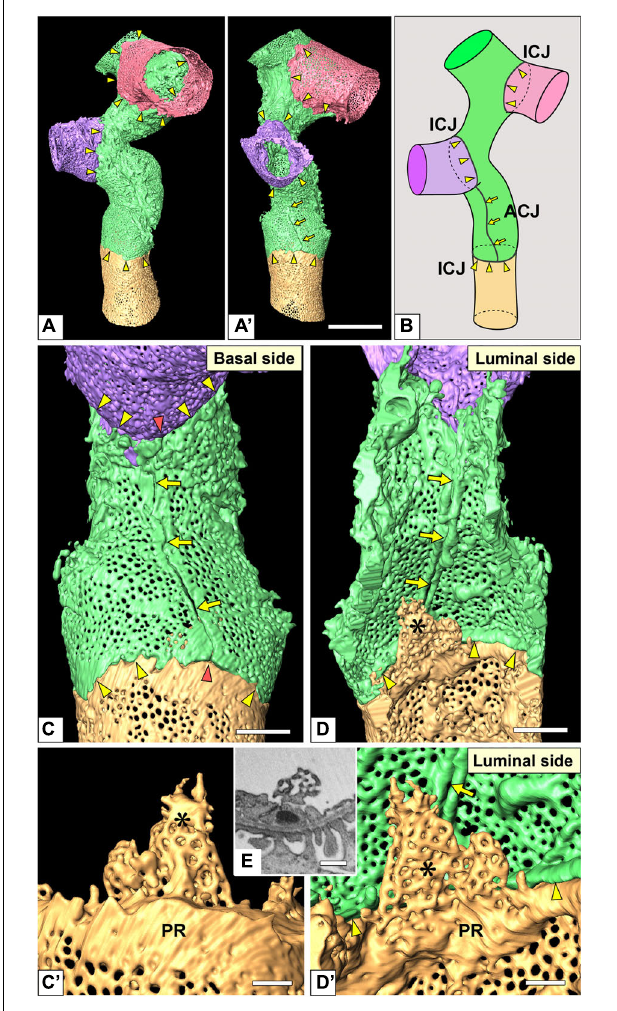
FIGURE 5 | Intercellular junction and autocellular junction (ACJ) of glomerular endothelial cells (GEnCs). (A) Reconstruction of a branching capillary formed by four GEnCs (purple, green, red, and yellow). (A (cid:48) ) View of the capillary shown in (A) from a different angle. (B) The location of cellular junctions in this capillary. The green GEnC forms an ACJ, which is along the longitudinal axis of the capillary. ICJ, intercellular junction between adjacent GEnCs. The basal (C) and luminal (D) surfaces of the urinary region. Two peripheral cytoplasmic ridges of the green GEnC are aligned in parallel to form an ACJ (arrows). The ACJ meets the ICJ to create “inverted T-shaped” seams (red arrowheads). Yellow arrowheads, ICJs between green and yellow GEnCs. (C (cid:48) ,D (cid:48) ) Magnified image of a reticular porous structure formed on the peripheral ridge (PR) of the yellow GEnC. (C (cid:48) ) The green GEnC is removed from (C) . (E) Focused-ion beam-scanning electron microscopy (FIB-SEM) image of the reticular porous structure shown in (C (cid:48) ,D (cid:48) ) . Asterisks, reticular porous structure. Scale bar, 10 µ m in (A (cid:48) ) ; 2 µ m in (C,D) ; 100 nm in (C (cid:48) ,D (cid:48) ,E) . The reconstructed images of GEnCs (A,A’,C,D) are also shown in Supplementary Movies 5, 6 .